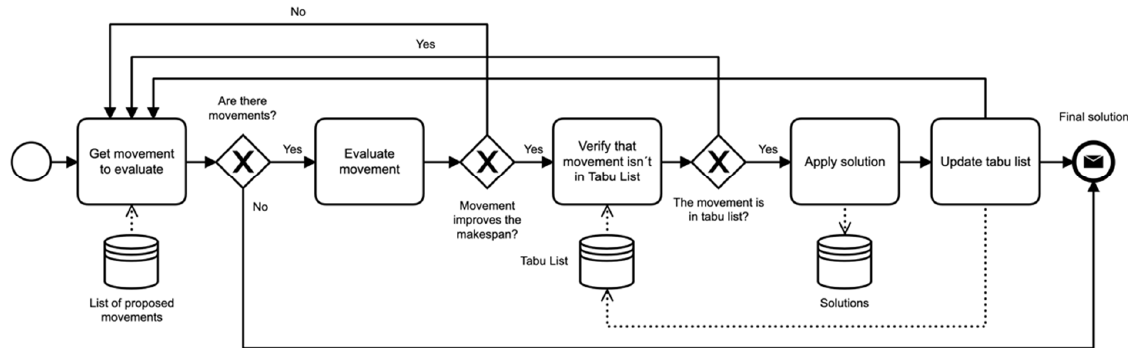
Figure 3. Selection of the best movement.